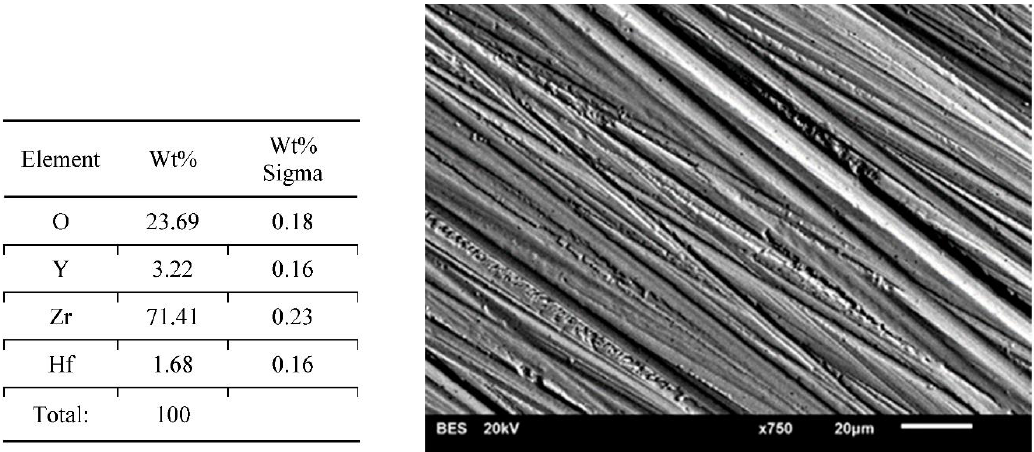
Figure 4. Chemical composition in presented area and a backscattered electrons image of sample—dry ground 120 grit paper. Coarse features and small arrachments on a surface.